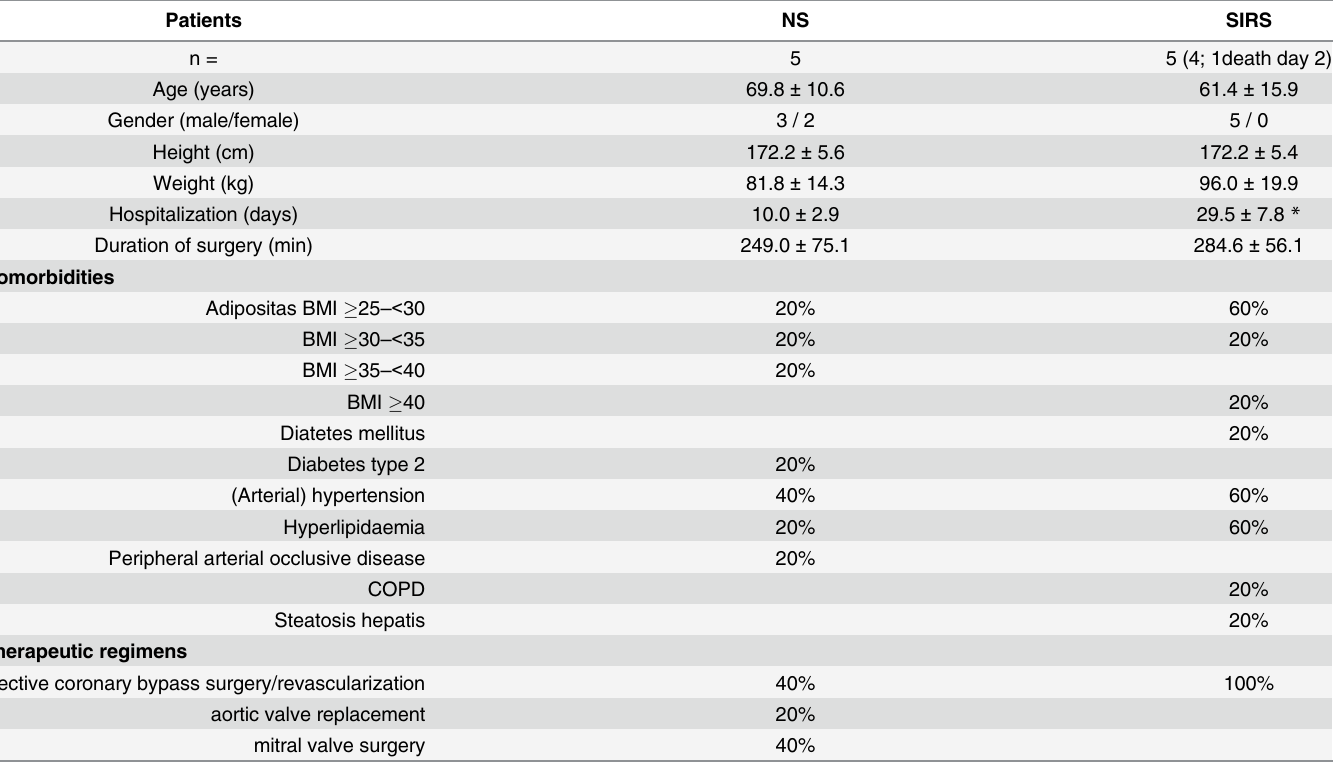
Table 2. Data of selected study subjects (5 per group aseptic (NS) and SIRS).